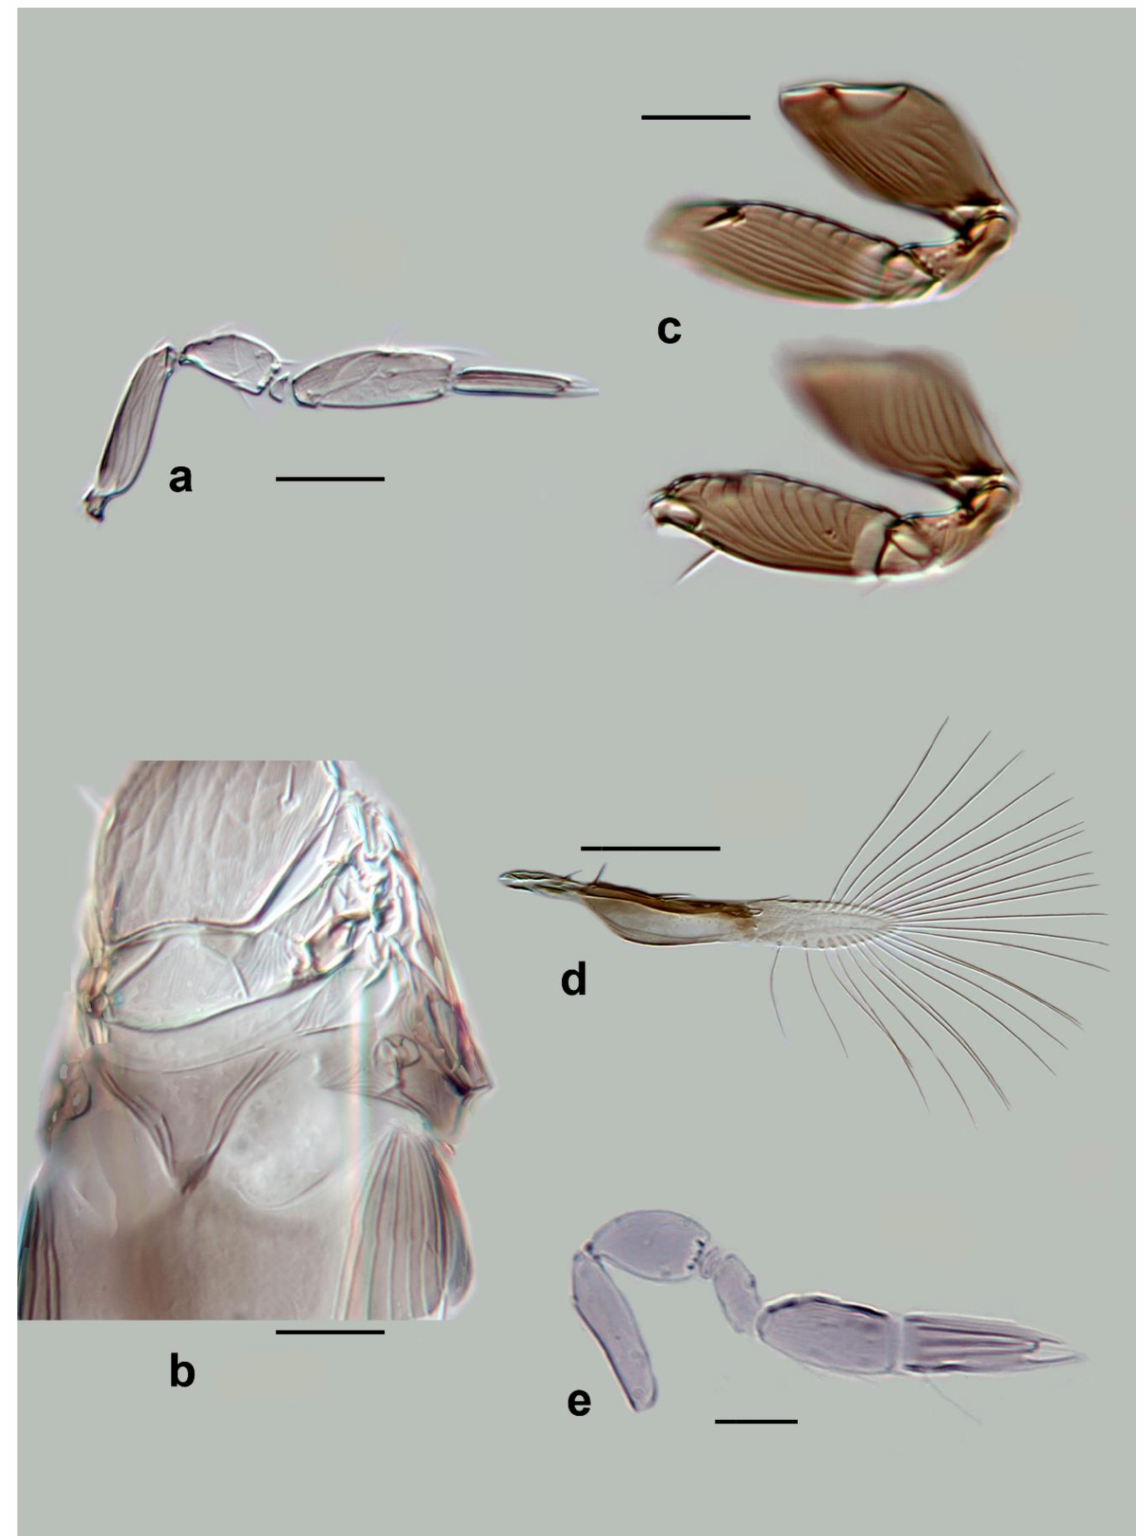
Figure 16. Photographs of Megaphragma species: ( a ) M. liui , female antenna; ( b ) M. liui , female dorsal meso- and metasoma (Holotype); ( c ) M. liui , female metacoxa and metafemur (Holotype); ( d ) M. liui , female fore wing (Holotype); ( e ) M. longiciliatum , female antenna (Holotype). Scale bars 20 µ m except 50 µ m for